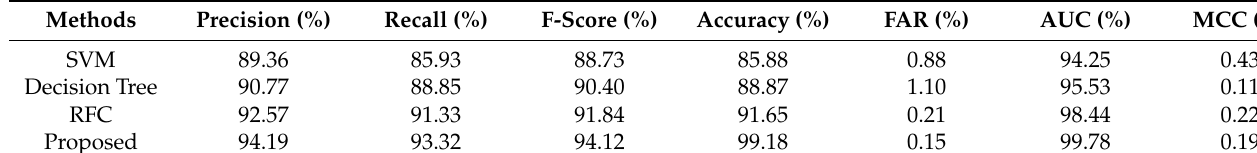
Table 4. Performance evaluation for the proposed SMO-HPSO for UNSW NB-15 Dataset.